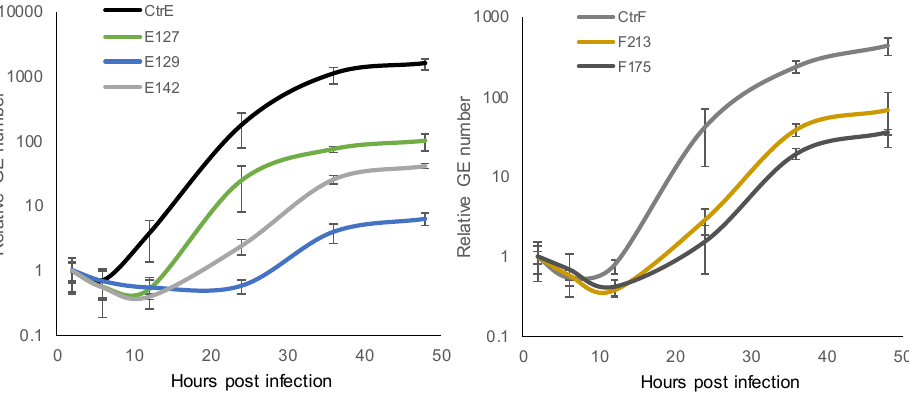
Figure 1. Growth kinetics of C. trachomatis reference strain type E (CtrE) and clinical isolates type E (E127, E129, and E142), and reference strain type F (CtrF) and clinical isolates type F (F213 and F175) at 2, 6, 12, 24, 36, and 48 hours post infection (hpi) in HeLa229 cells determined with